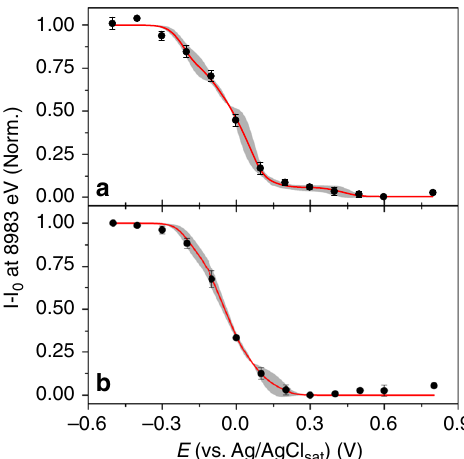
Fig. 5 Obtaining information from individual and consecutive redox reactions. Titration curves for the experiments ( a ) in the absence of oxygen and ( b ) in the absence of oxygen. Dots represent the experimental data points; red lines are the fi tted curve for the cumulative four 1-electron reduction; and gray shades represent the area- fi lled error obtained between the fi ts.